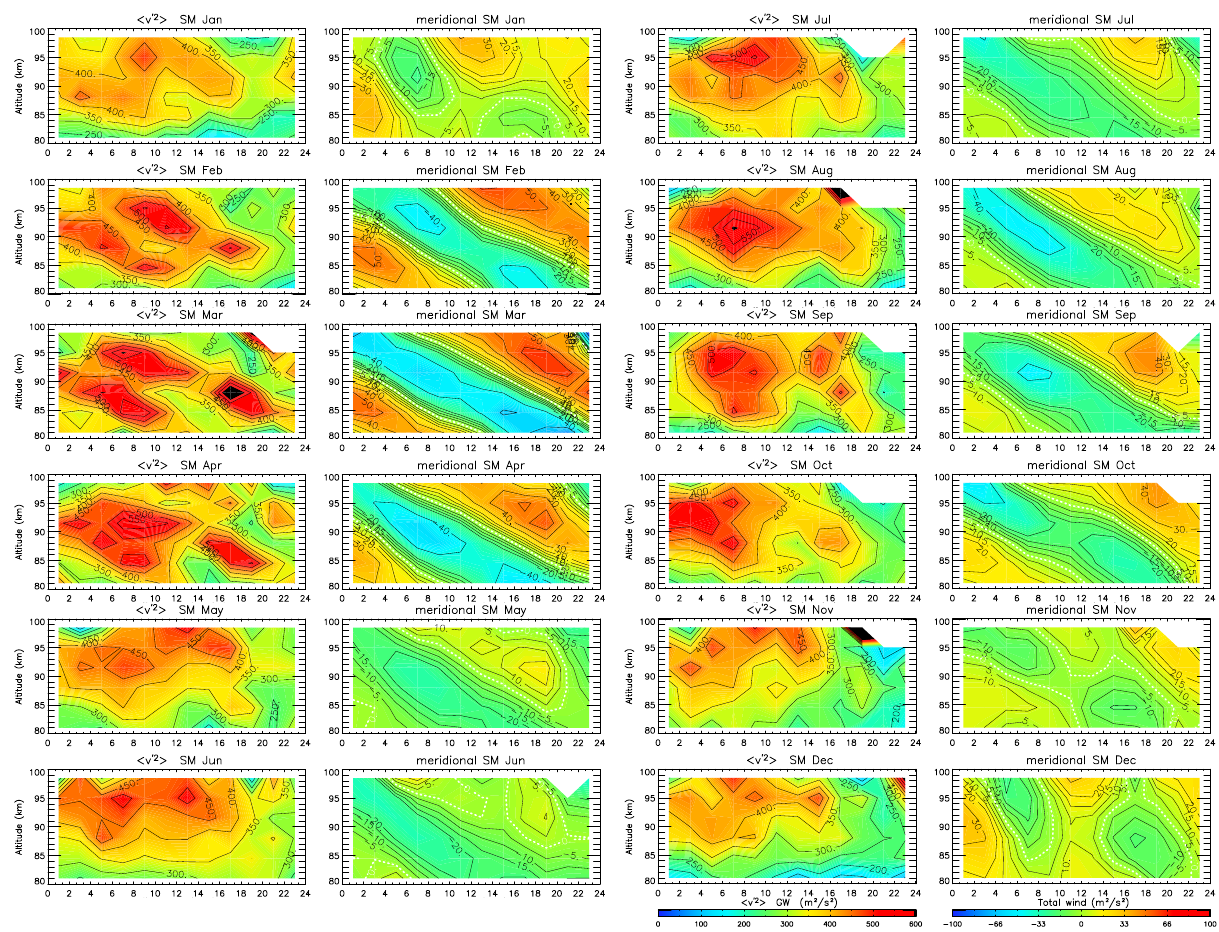
Fig. 10. The same as Fig. 9, but for the meridional